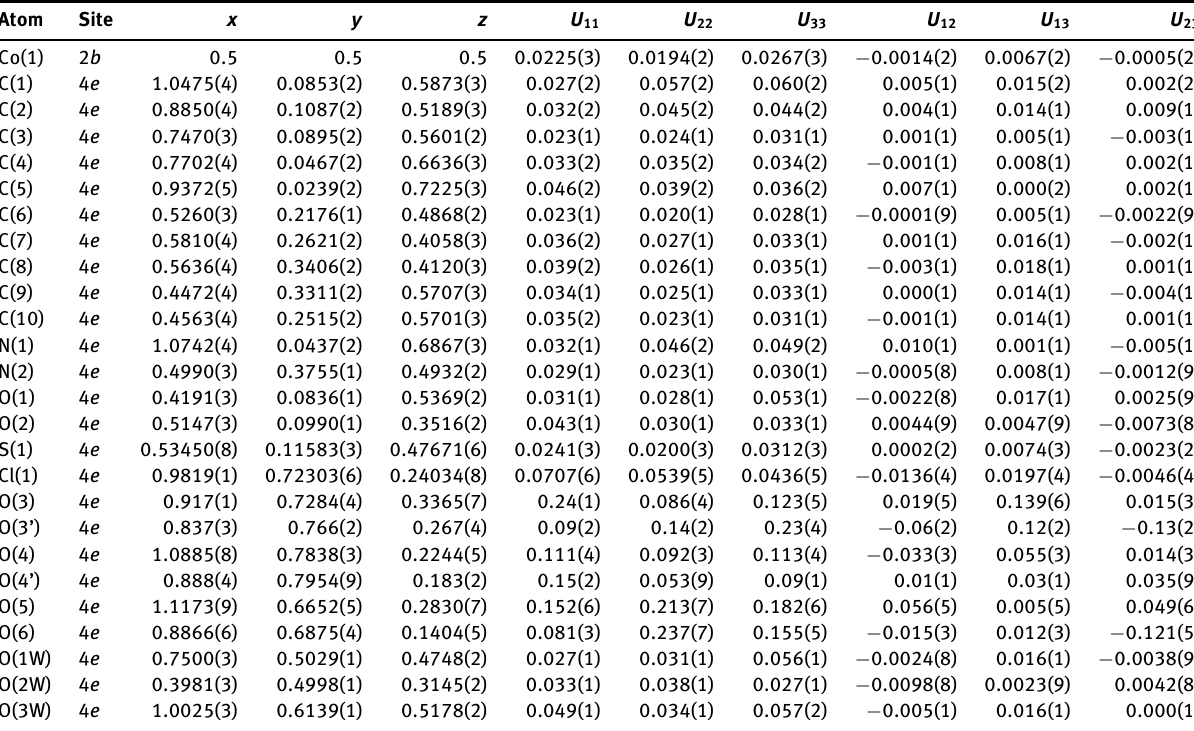
Table 3: Atomic displacement parameters (Å 2